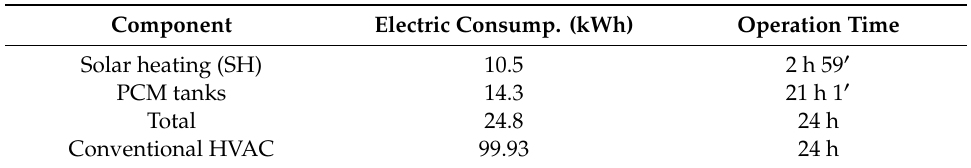
Table 5. Average daily consumption of the solar driven heating system and the operation times of every component. A conventional heat pump is included for